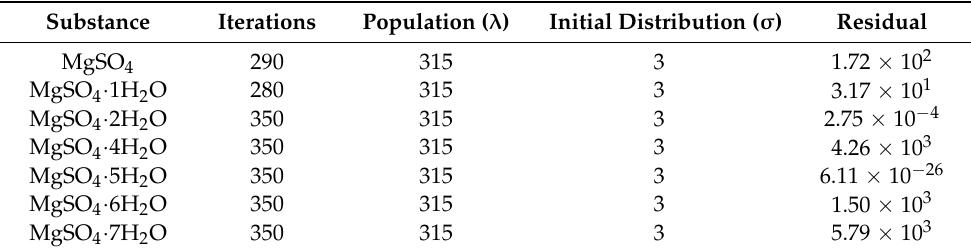
Table 6. Parameters of the simulation for the fitting of the heat capacities and final residual of the